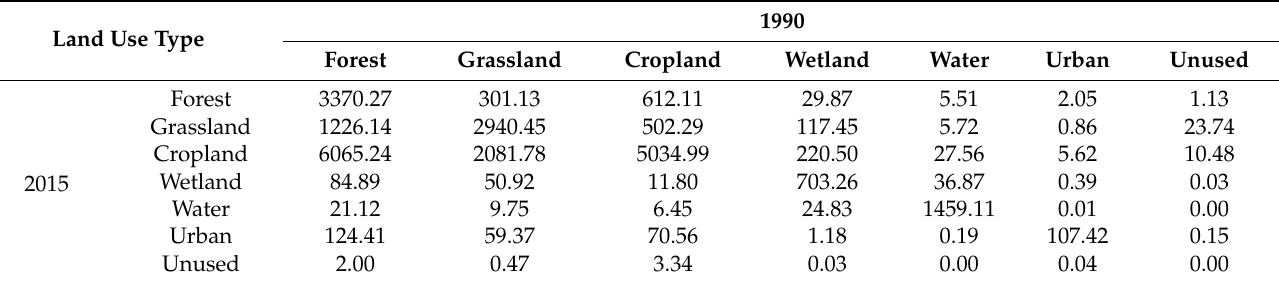
Figure 5. Land use area of Rwanda from 1990 to 2015. Table 2. Transfer matrix of land use types in Rwanda from 1990 to 2015 km 2 .